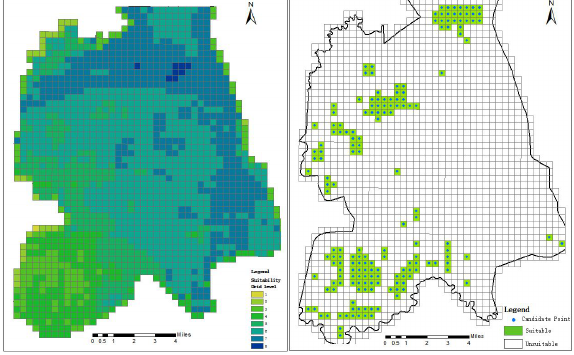
Figure 9. Distribution of suitable locations and candidate points.